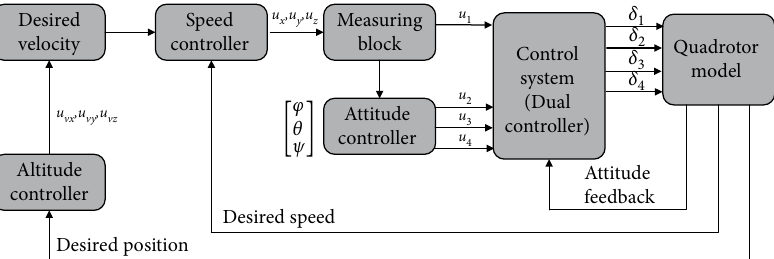
Figure 2: Block diagram of quadrotor UAV.